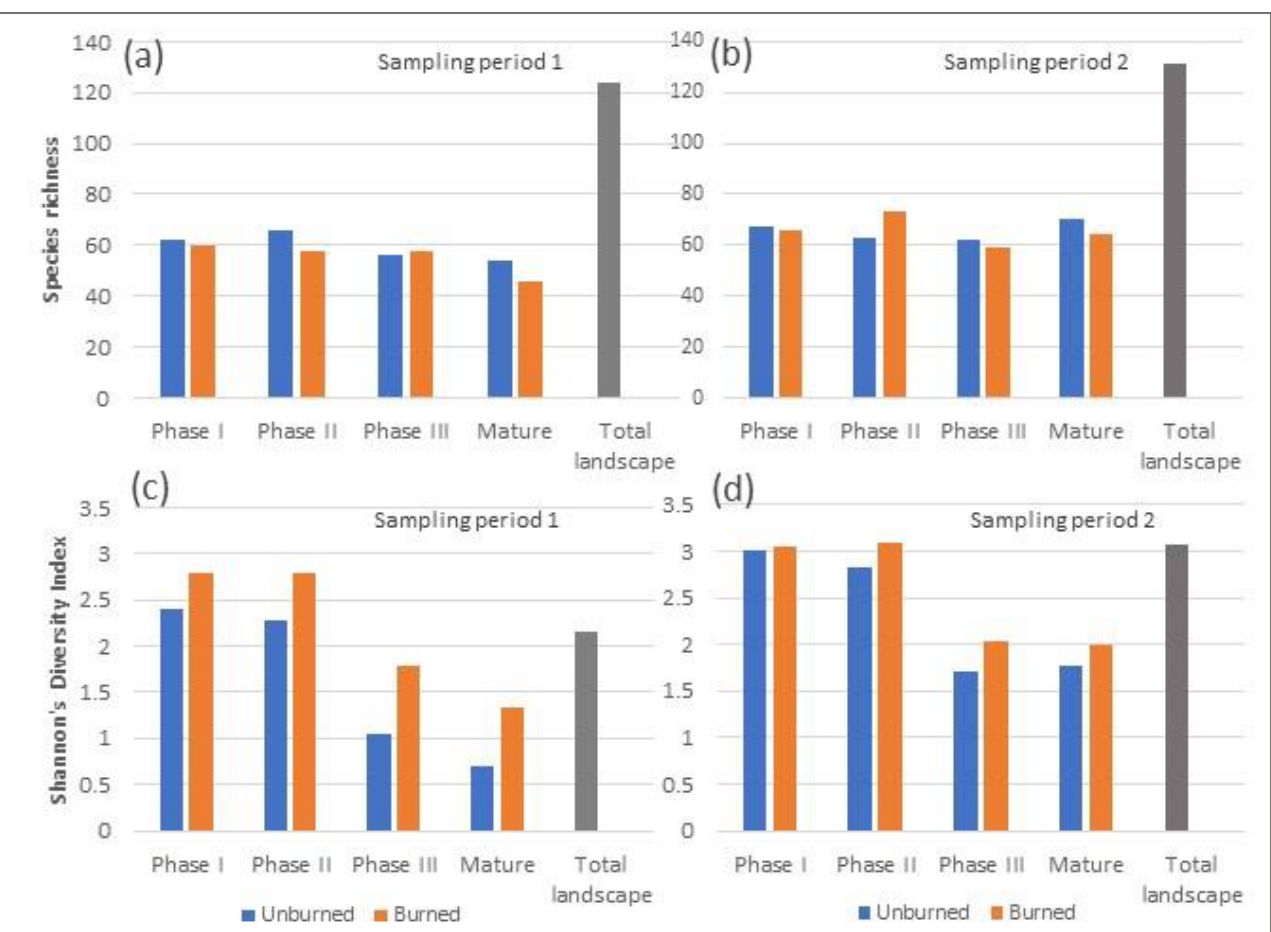
Figure 4. Total species richness ( a , b ) and diversity ( c , d ) for each woodland development stage (unburned and burned) and for the total landscape for the two sampling periods.